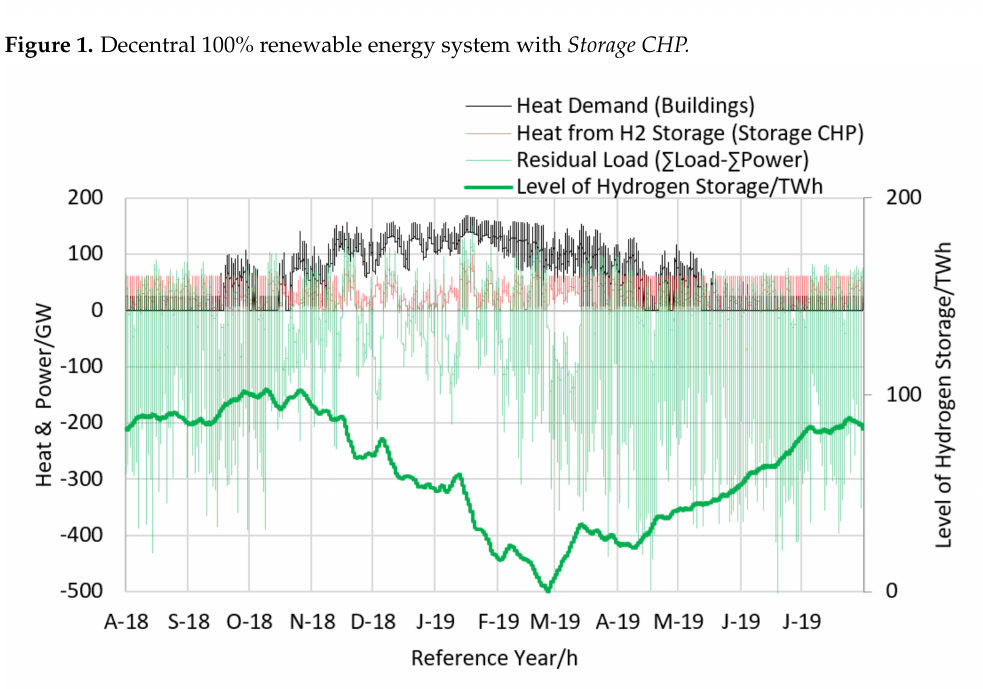
Figure 2. Heat from hydrogen conversion in a building integrated with Storage CHP covers significant shares of the heat demand in Germany’s buildings in 2030, especially in winter (center). Negative residual power (green) is used for electrolysis, positive residual power starts up the fuel cells. Curtailment: 3.4%. Hydrogen storage capacity is 103 TWh (right axis) for the standard scenario with 400 GW